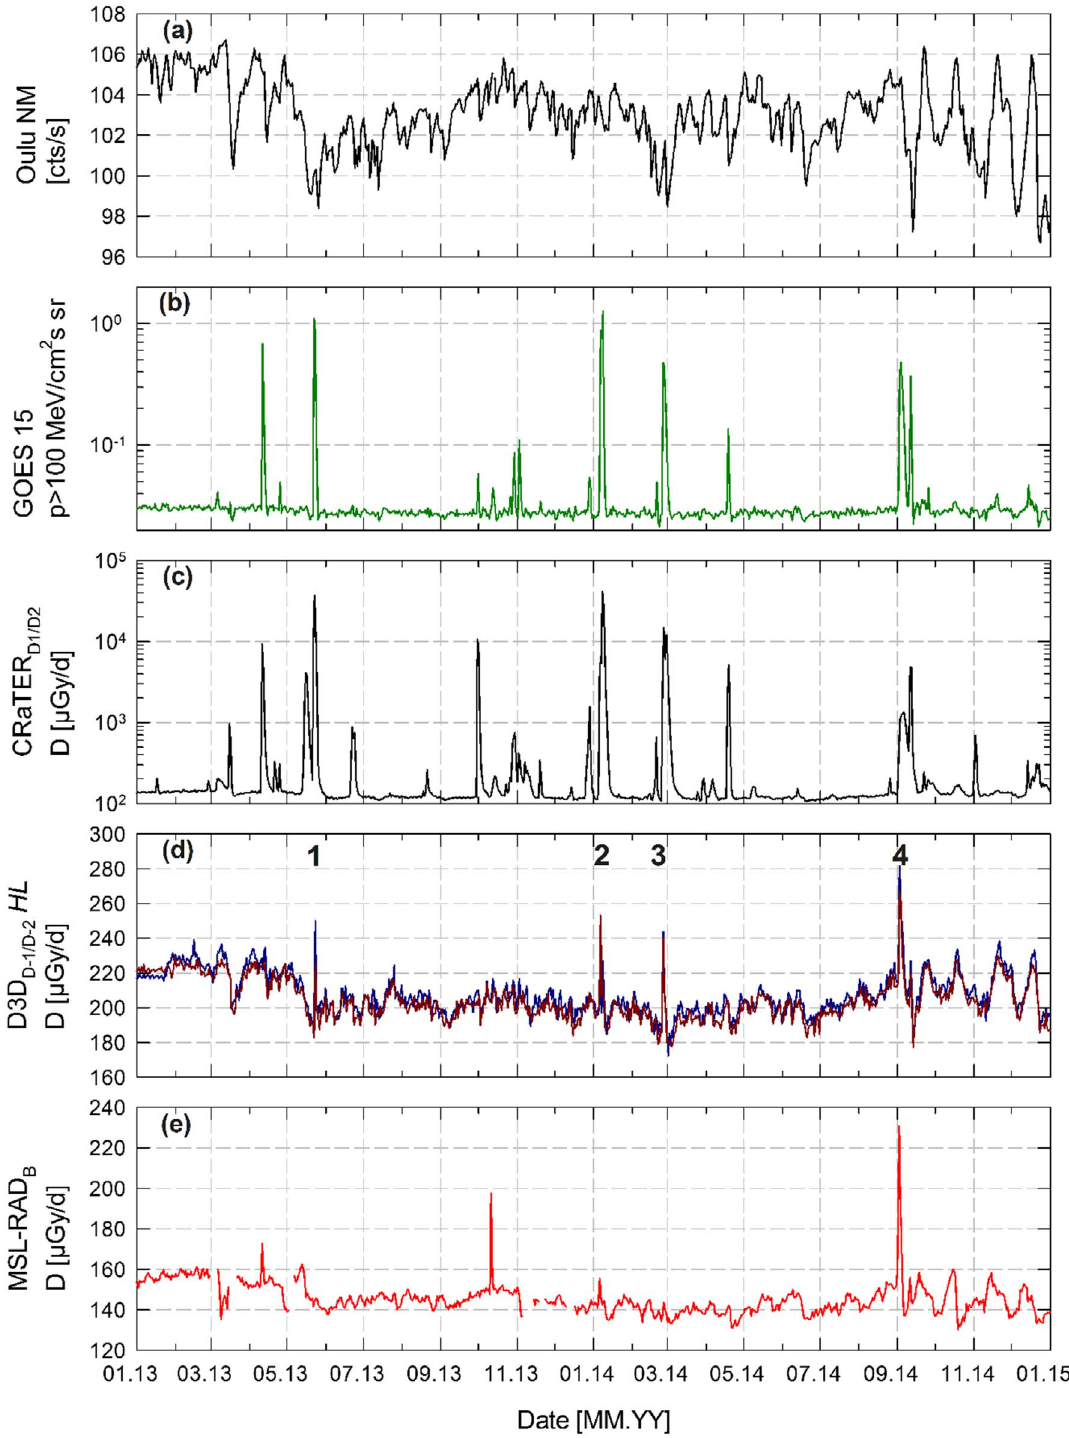
Fig. 10. (a) Oulu NM count rates; (b) GOES 15 proton fl ux > 100 MeV; (c) daily dose rates for CRaTER D1/D2 ; (d) daily dose rates for D3D D-1 (dark blue) and D3D D-2 (dark red) based on HL -value cut; Numbers (1 – 4) correspond to the events listed in Table 4; and (e) daily dose rates measured with the MSL-RAD B detector for the same time